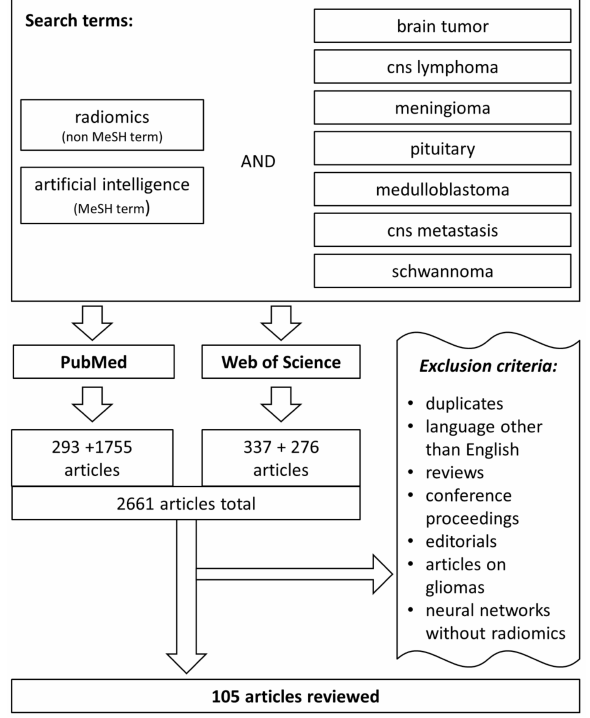
Figure 1. The representation of the article selection